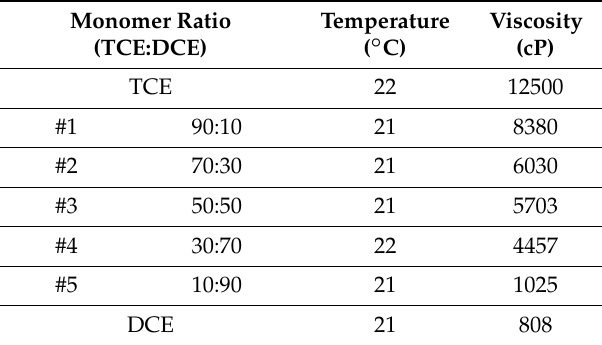
Figure 2. Core-shell-like microcapsules of TCE-co-DCE. ( a ) Schematic process of polymerization and fabrication of microcapsules. ( b ) Digital images of TCE-co-DCE particle emulsion in the flask, synthesized with different ratios of TCE to DCE. #1: 90, #2: 70, #3: 50, #4: 30, #5: 10. Inset: SEM images of microcapsules. Table 1. Viscosity value by monomer ratio.